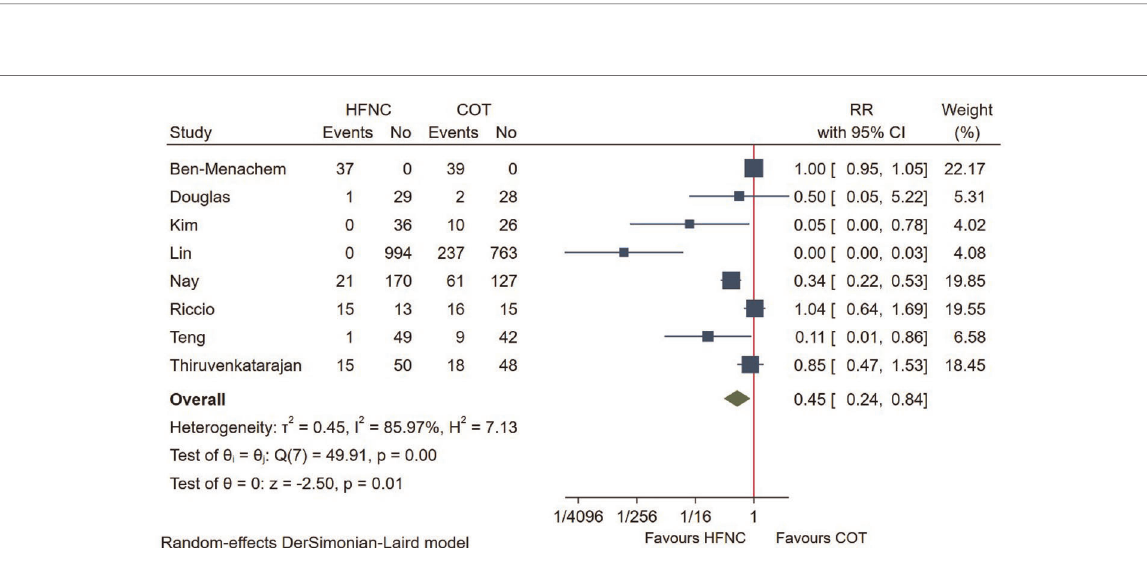
FIGURE 4 Forest plot comparing end-procedure partial pressure of CO2 during the procedure in HFNC versus COT. HFNC, high fl ow nasal cannula; COT, conventional oxygen therapy; SMD, standard mean difference.